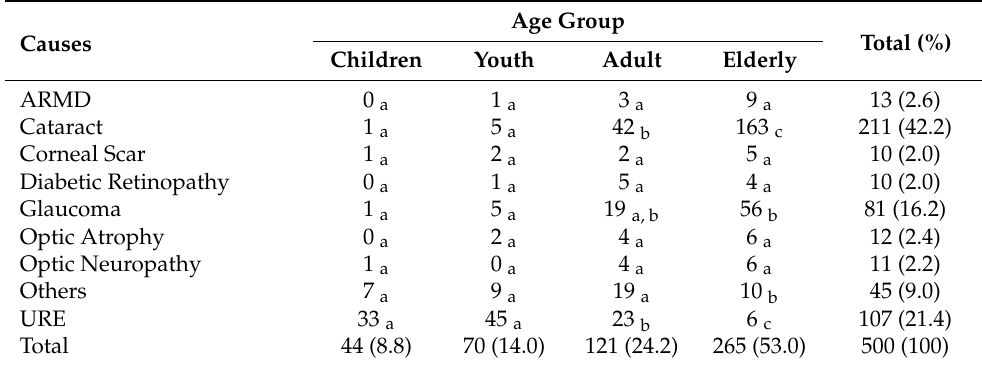
Table 5. Association between age groups and causes of VI and blindness.